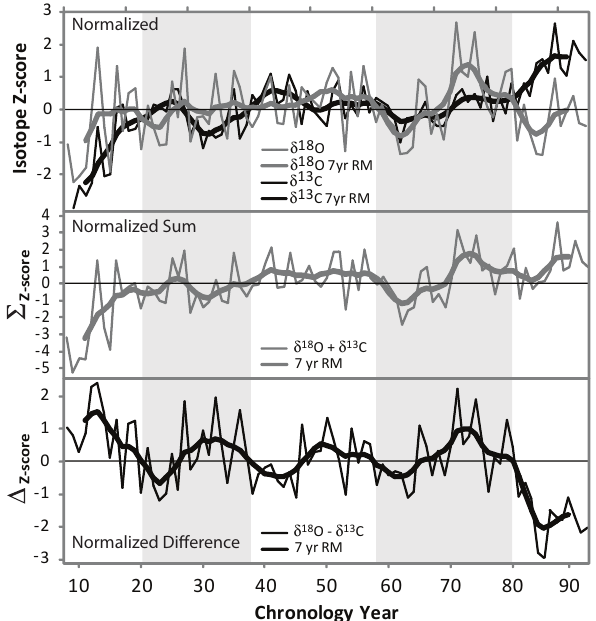
Figure 6. Results of dual-isotope ( δ 18 O and δ 13 C) analysis ( n = 86). Upper panel: normalized δ 18 O ( δ 18 O Z-score , thin gray line) and δ 13 C ( δ 13 C Z-score thin black line), and 7-year triangu- lar running mean δ 18 O Z-score (bold gray line) and δ 13 C Z-score (bold black line). Enter panel: sum of δ 18 O Z-score and δ 13 C Z-score ( (cid:54) Z-score , thin gray line), and 7-year triangular running mean (bold gray line). Lower panel: difference of δ 18 O Z-score minus δ 13 C Z-score ( (cid:49) Z-score , thin black line), and 7-year triangular run- ning mean (bold black line). Shaded regions in upper and lower panels highlight the bidecadal oscillations evident in the (cid:49) Z-score chronology in the lower